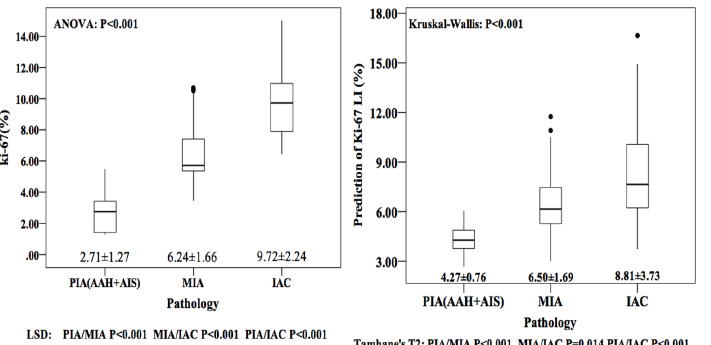
Fig 7. Boxplots comparing the mean predictive Ki-67 labeling index (LI) with mean actual measured Ki-67 LI of preinvasive adenocarcinoma (PIA), minimally invasive adenocarcinoma (MIA) and invasive adenocarcinoma (IAC). Predictive Ki-67 LI and actual measured Ki-67 LI were all significantly different among PIA, MIA and IAC.